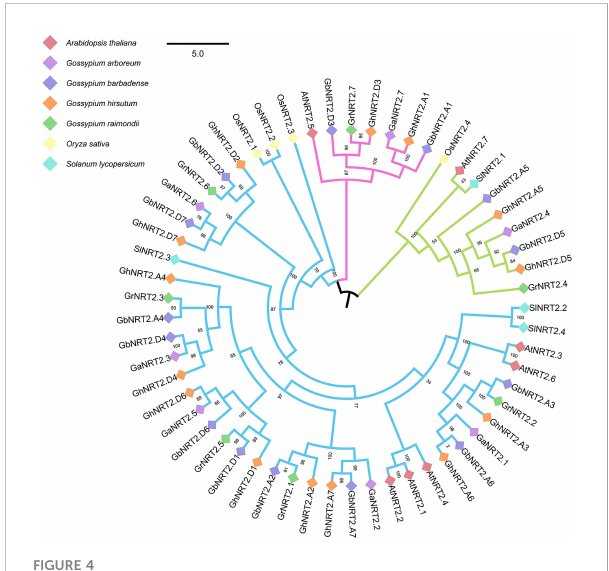
FIGURE 4 Phylogenetic analysis of NRT2 gene families Phylogenetic analysis of the NRT2 gene families in cotton, Arabidopsis, rice, and tomato. Different groups are colored by a special line. Different plants use small squares of different colors. The number beside the branch indicates the bootstrap value of each group from 1,000